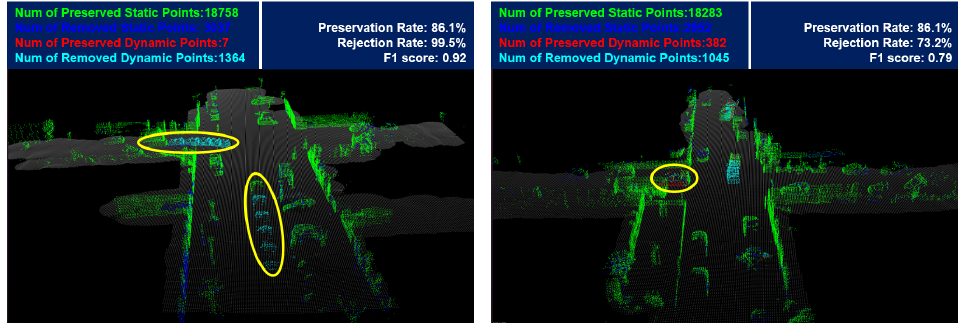
Figure 10. The two moving vehicles (outlined by the yellow ellipse) shown in the left figure have been correctly identified as moving objects. Therefore, the rejection rate is as high as 99.5%. The vehicle shown in the right figure has not been identified as moving object, hence results in a low rejection rate of 73.2%.